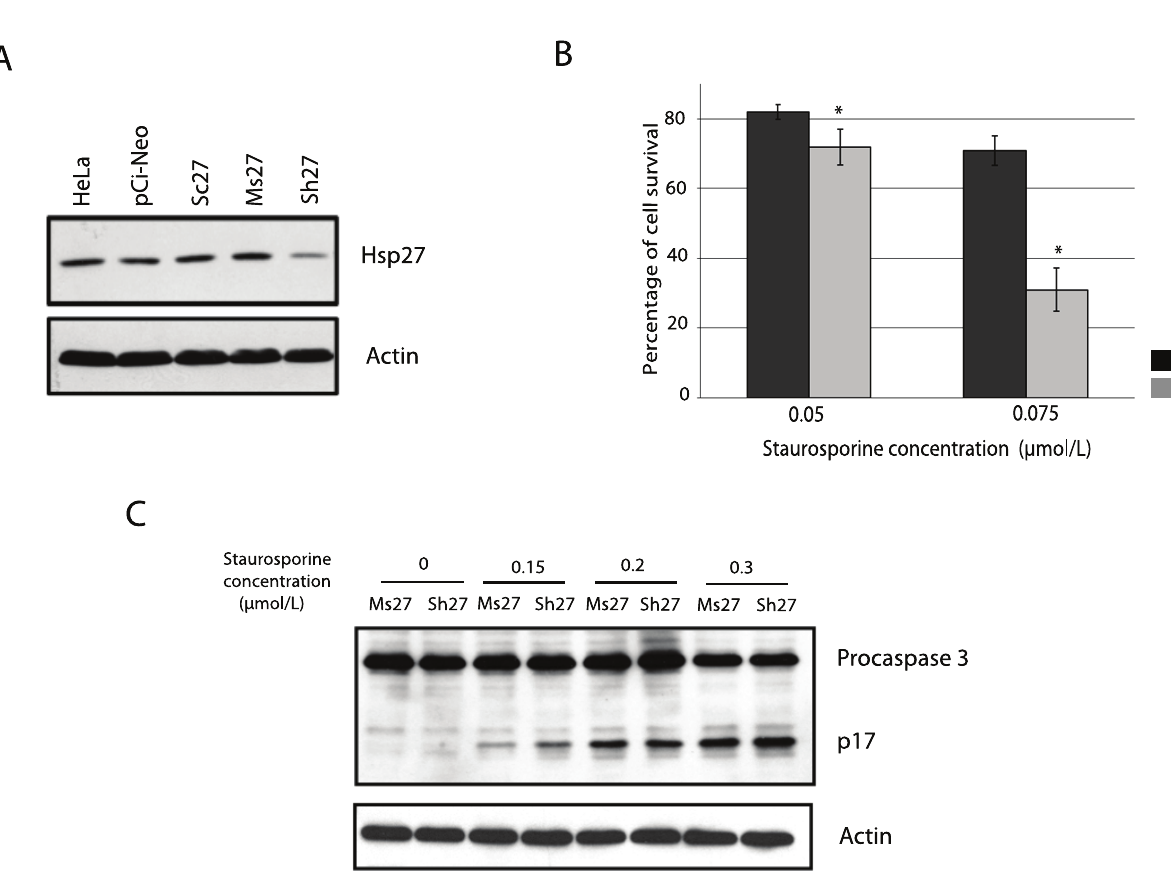
Figure 1. Transient down regulation of Hsp27 protein by shRNA sensitizes HeLa cells to cell death and promotes apoptosis. A , pCI- Neo, pSuperNeo-ScRNA27 (Sc27), pSuperNeo-MsRNA27 (Ms27) and pSuper-ShRNA27 (Sh27) vectors were transiently expressed in HeLa cells. Samples were collected 48 h after transfection and Hsp27 level was analyzed by western blot. Level of actin was used as control. B , Sensitivity to cell death was determined by crystal violet analysis, as described in Materials and methods. Staurosporine, a pro-apoptotic kinase inhibitor, was used to induce apoptosis ( p , 0.01). C , HeLa cells, treated for 4 h with different concentrations of staurosporine, were analyzed by western blot using an anti- caspase3